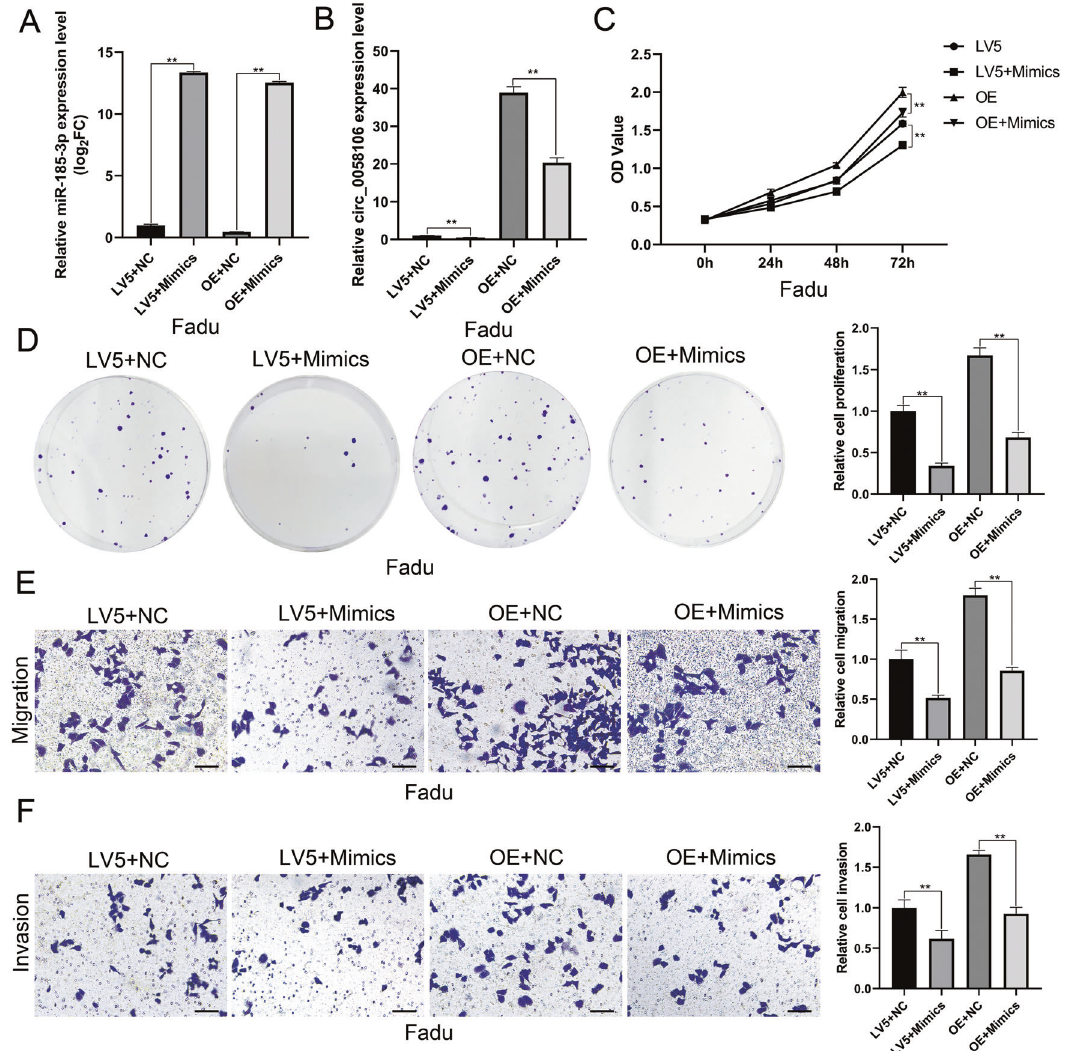
measured by CCK8 assay at 0, 24, 48 and 72 h ( n = 3, * P < 0.05; ** P < 0.01) D Proliferation of circ_0058106-OE or LV5 Fadu cells after transfected with miR-185-3p mimics or negative control was measured by colony formation assay. ( n = 3, * P < 0.05; ** P < 0.01) E Migration of negative control was measured by transwell invasion assay. (Scale bars = 100 μ m, n = 3, * P < 0.05; ** p <